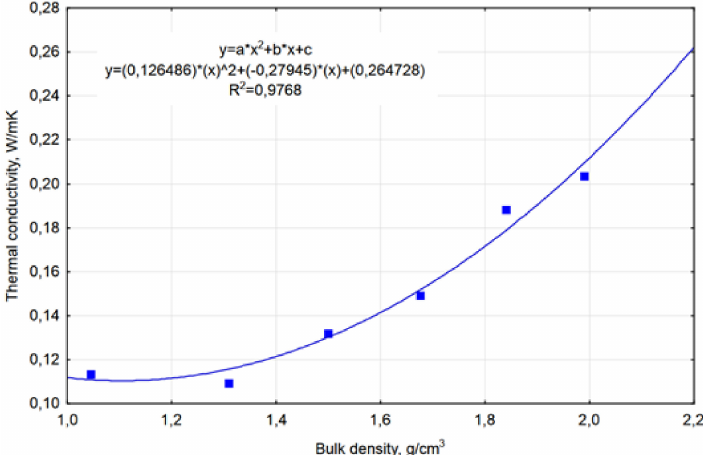
Figure 8. Graph of the function describing the dependence of the thermal conduction coefficient on the bulk density of the mortar